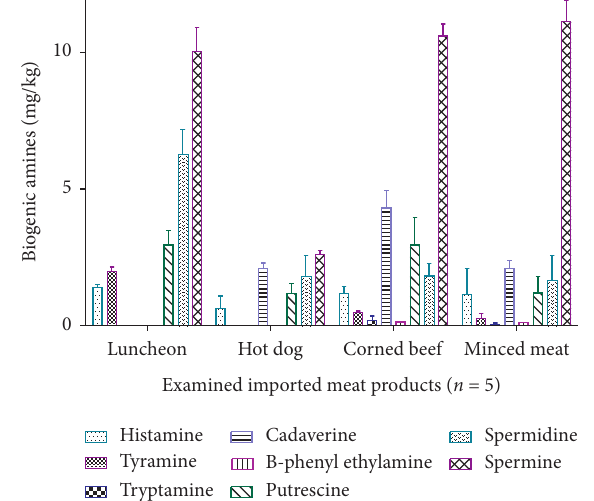
Figure 2: Biogenic amine levels (mg/kg) in examined imported meat products ( n �